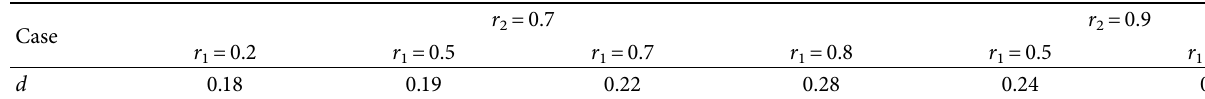
Figure 7: Division of the region of the coupling amplification effect. Table 1: The values of d .